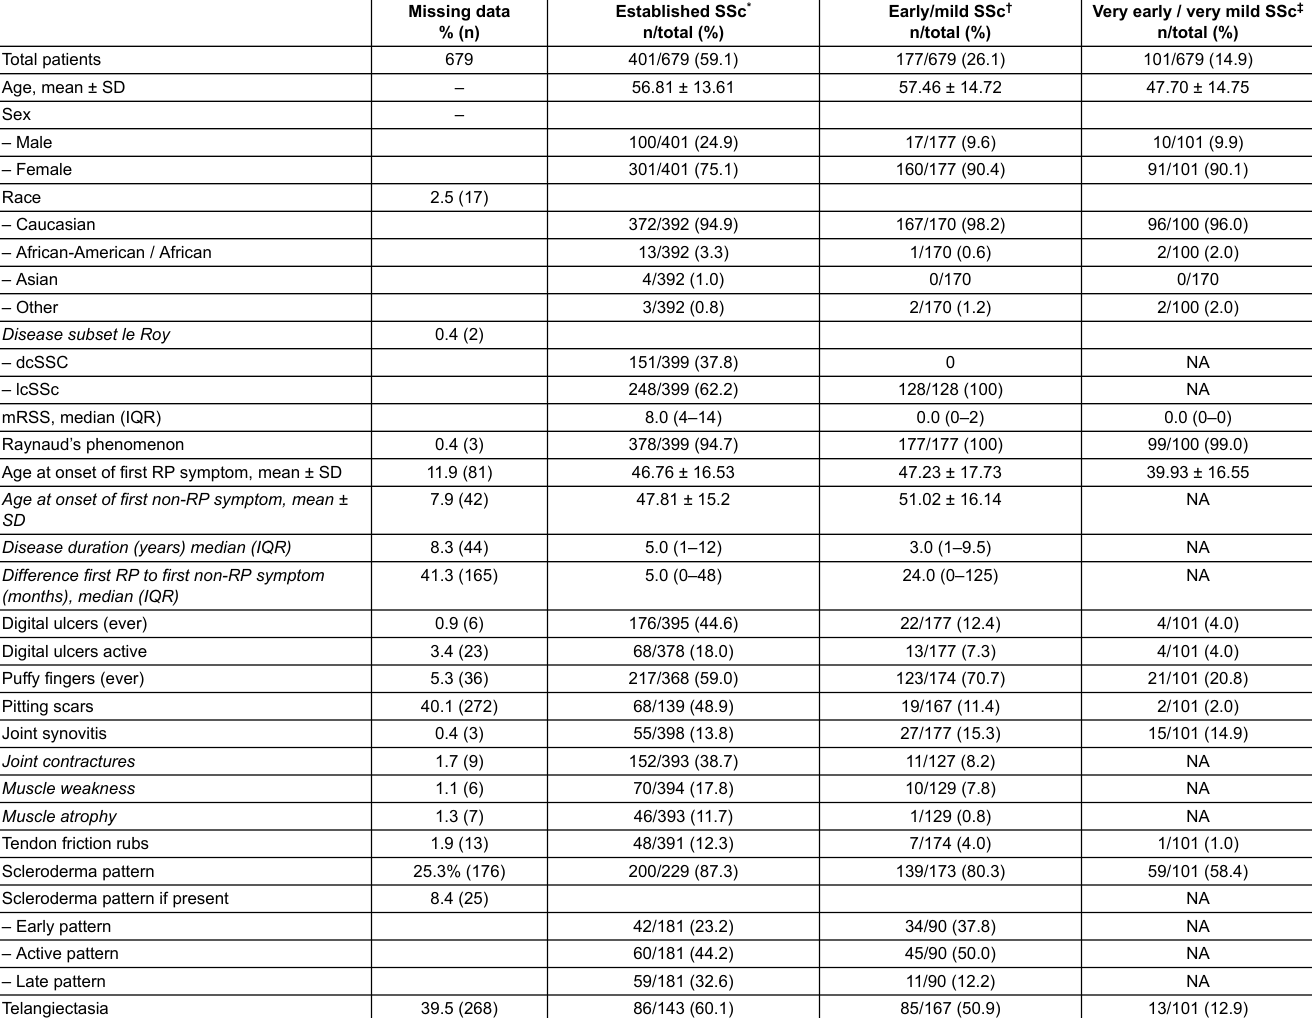
Table 1: Demographic and disease characteristics of Swiss SSc patients